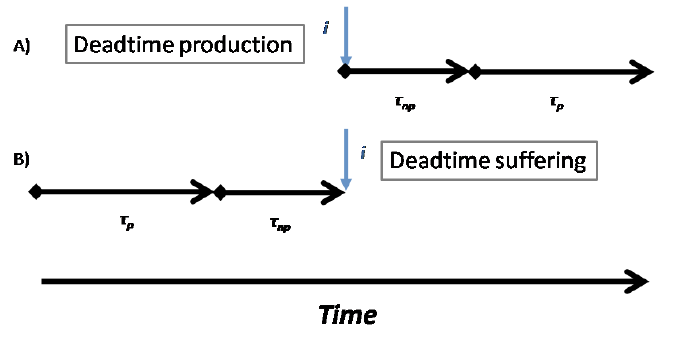
Figure 1. (A) Structure of the two DT produced in a hybrid DT model. (B) Time intervals rate that produces losses into the following i-th instant and type of DT losses